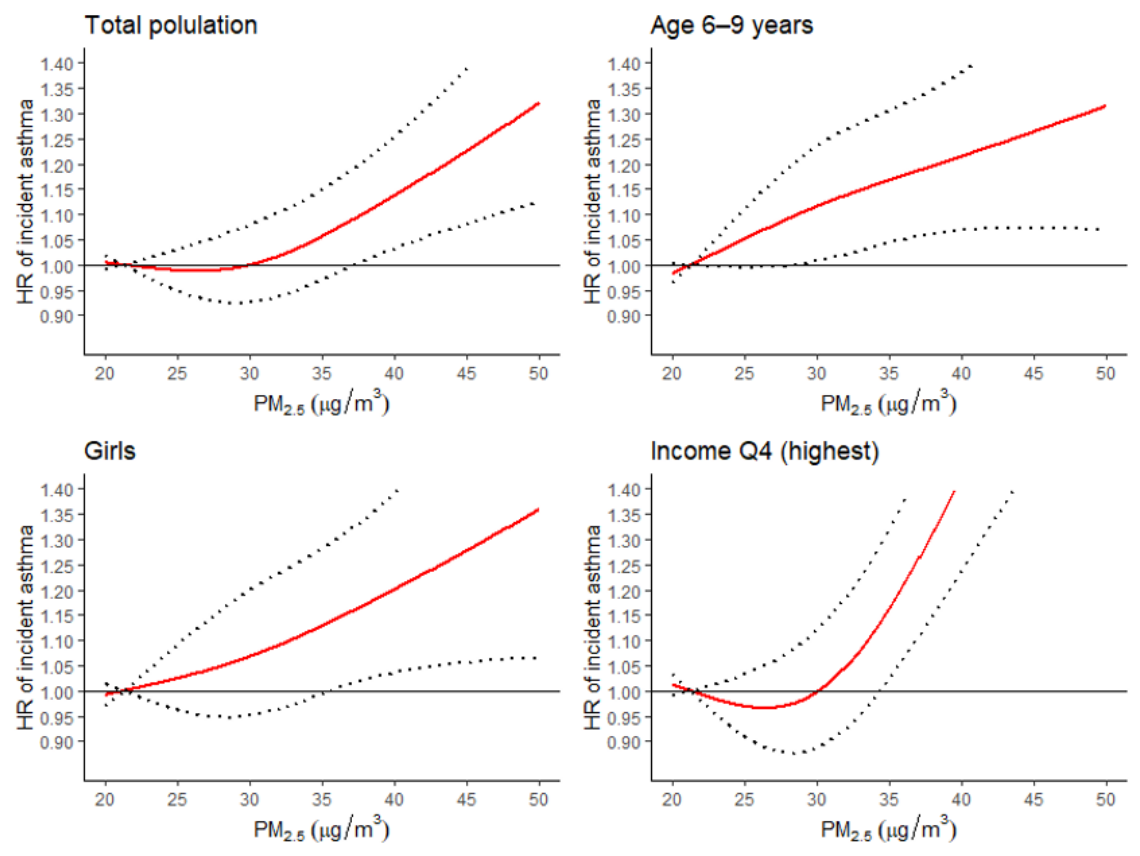
Figure 3. Hazard ratio plot of the 48-month moving average of PM 2.5 levels for asthma incidence. Red line, hazard ratio (HR) of incident asthma by PM 2.5 levels; Dotted line, 95% confidence intervals of HR of incident asthma by PM 2.5 levels; Black line, the reference line with HR of 1.